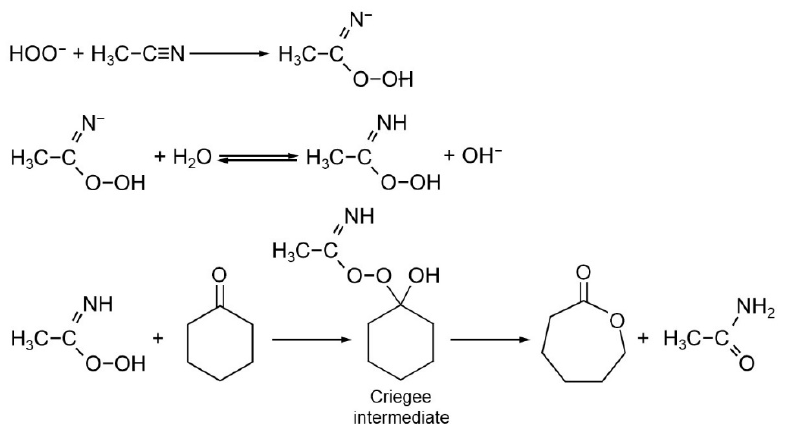
Figure 5. Reactions involved in the oxidation of cyclohexanone to ε -caprolactone with H 2 O 2 /acetonitrile with the HT catalyst.